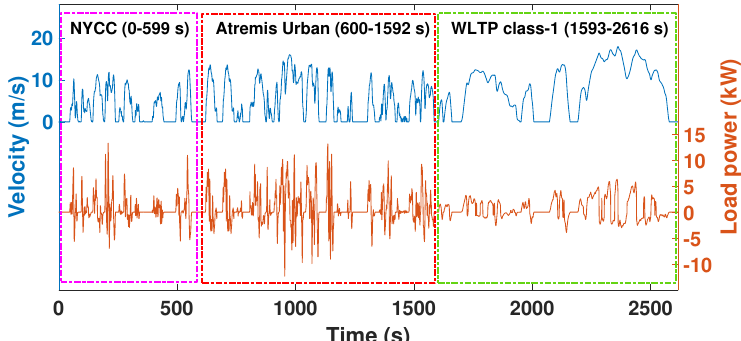
Figure 4. Velocity profile of NYCC, Artemis Urban, and WLTP